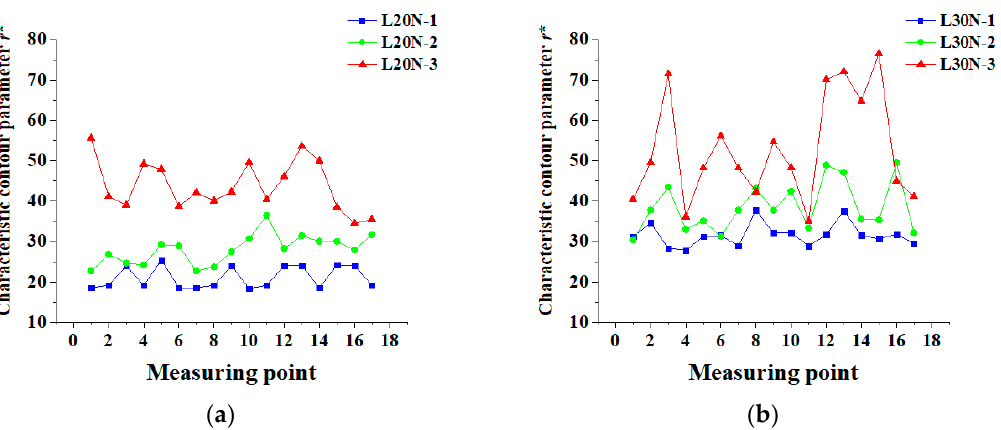
Figure 8. Distribution of r* along the longitudinal axis: ( a ) L20N; ( b ) L30N.